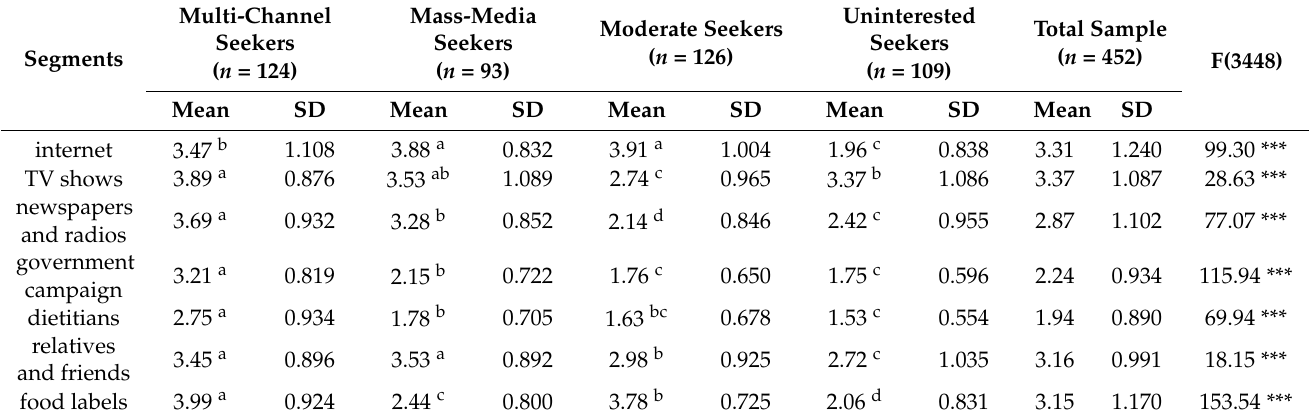
Table 1. Descriptive of the segments and MANOVA